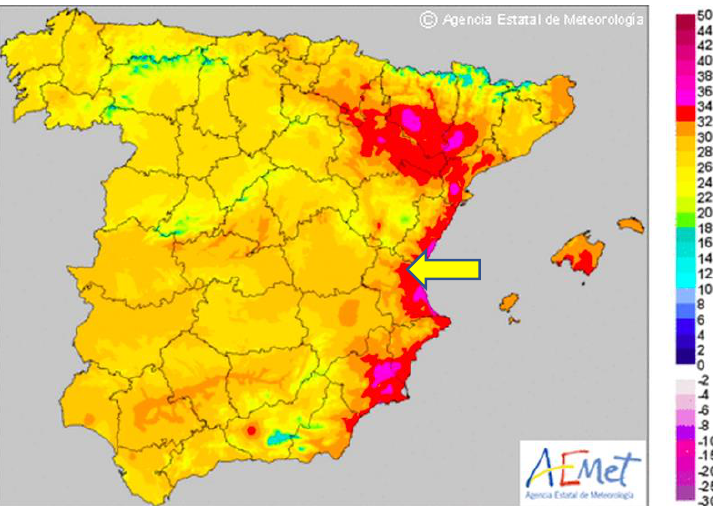
Figure 5. This map shows the maximum temperatures on one of the three days of the clinical study (the arrow indicates the province of Valencia (Spain), where this clinical study was carried out) (Source: Spanish Meteorology Agency AEMET).